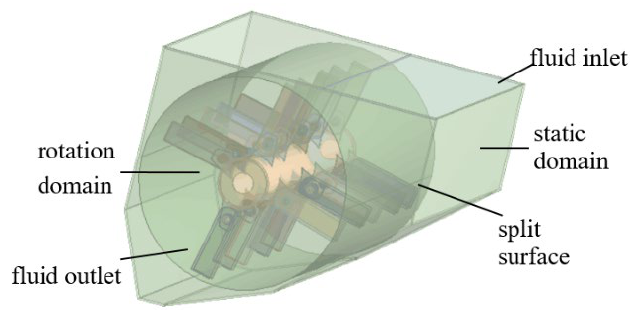
Figure 5. Simplified CC structure.